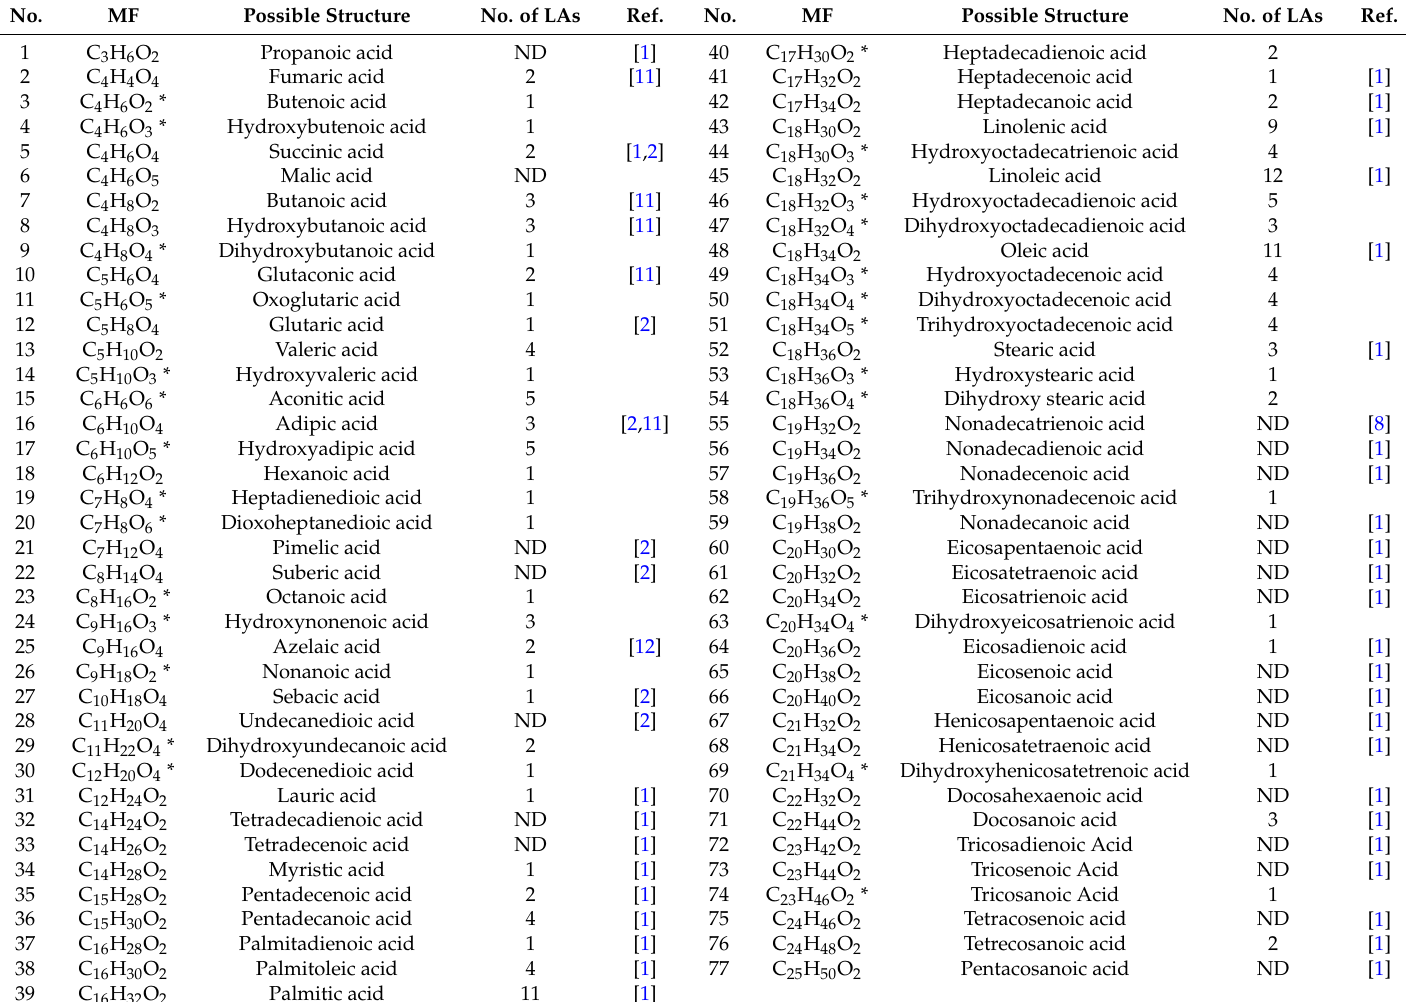
* Indicates the side chains detected for the first time; MF: molecular formula; LAs: lipo-alkaloids; ND: not